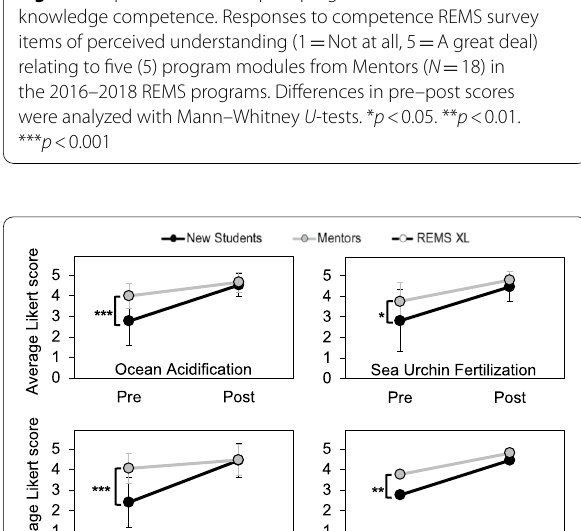
Not at all, 5 A great deal) = = 18) in =